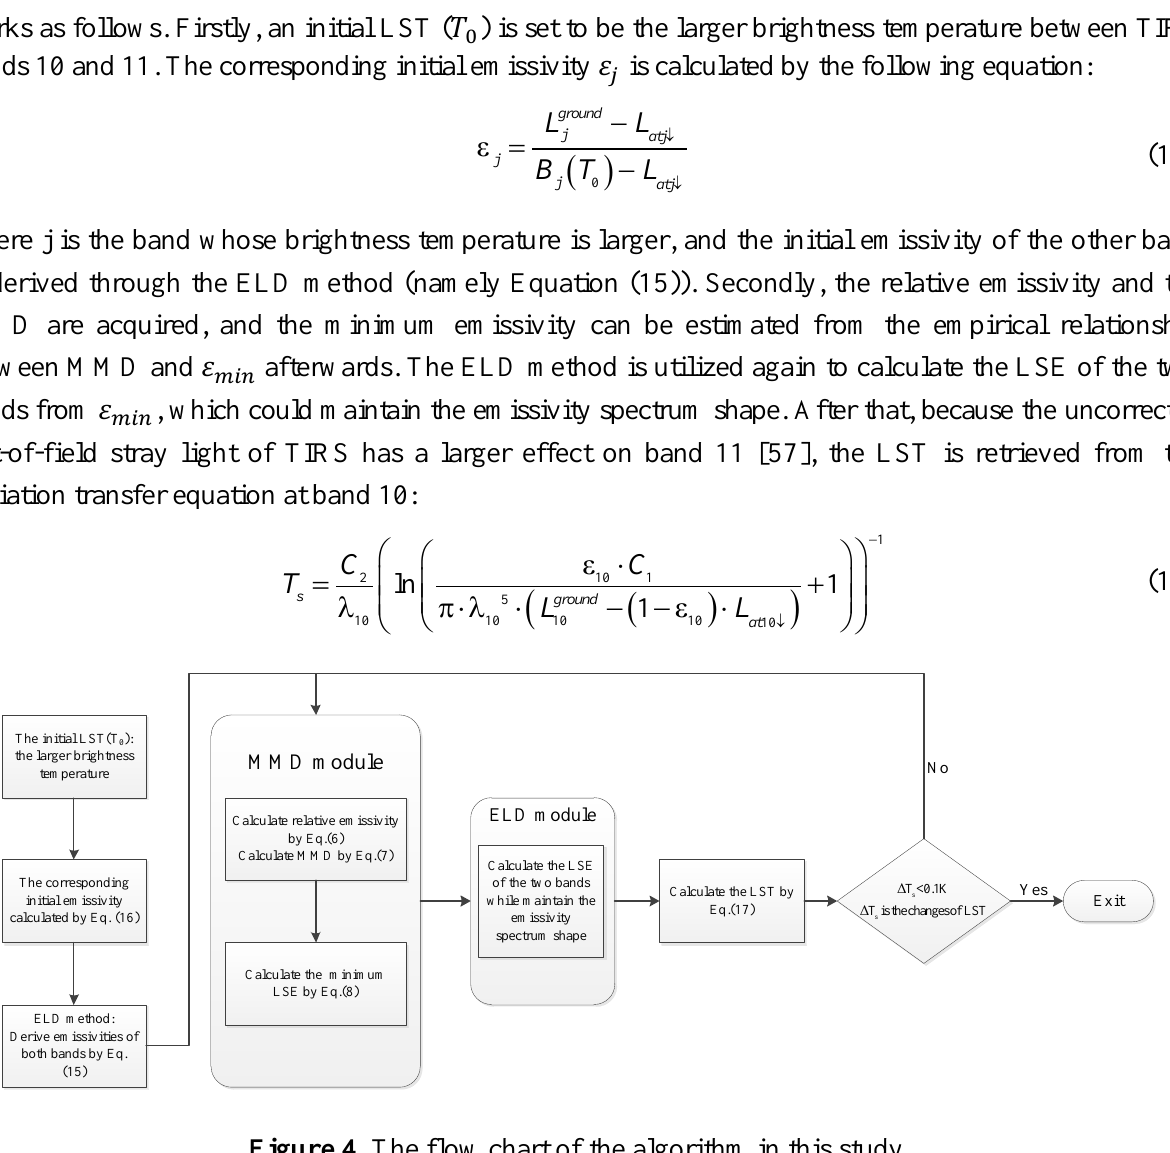
Figure 4. The flow chart of the algorithm in this